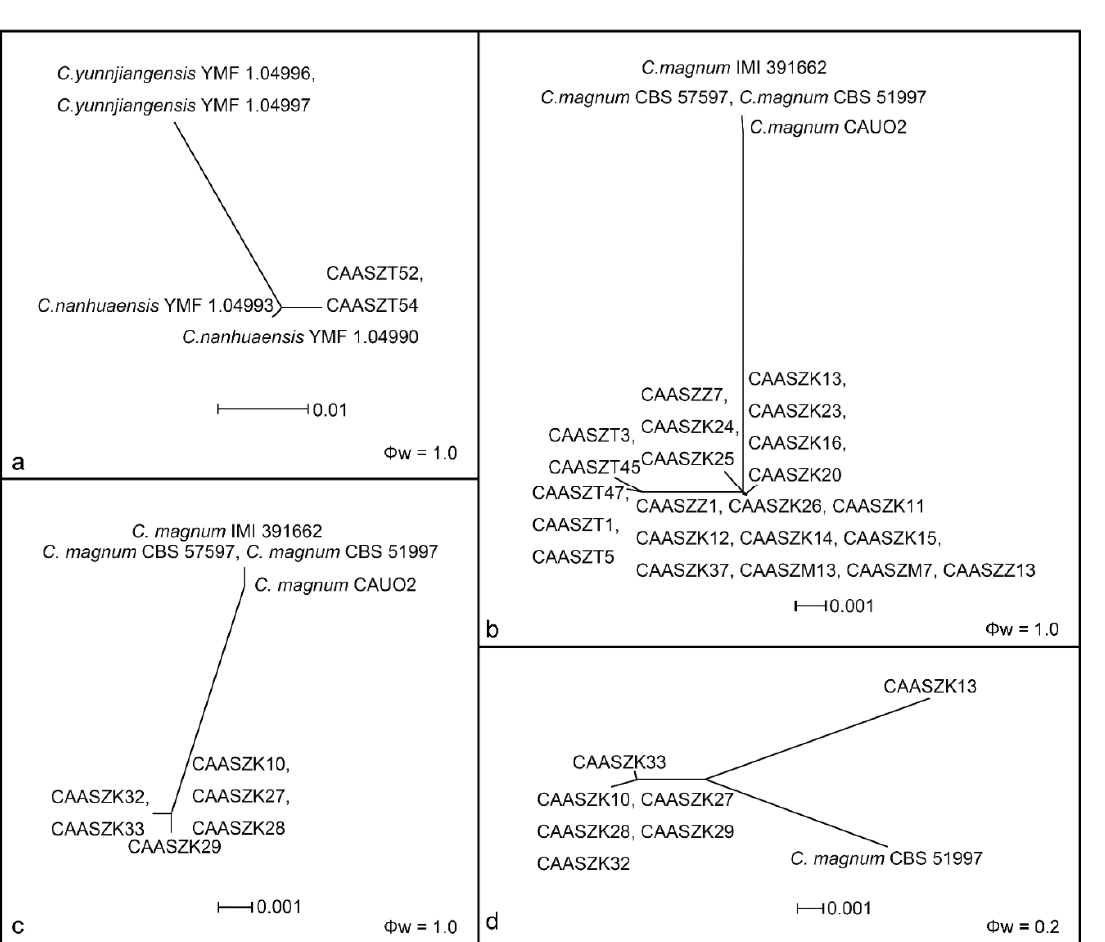
Figure 8. The result of the pairwise homoplasy index (PHI) tests of closely related species using both LogDet transformation and Splits decomposition. The PHI of C. citrulli ( a ) or C. kaifengense ( b ) or C. qilinense ( c ) or C. kaifengense and C. qilinense ( d ) and their phylogenetically related isolates or species, respectively. PHI test value ( Φ w) < 0.05 indicate significant recombination within the dataset.